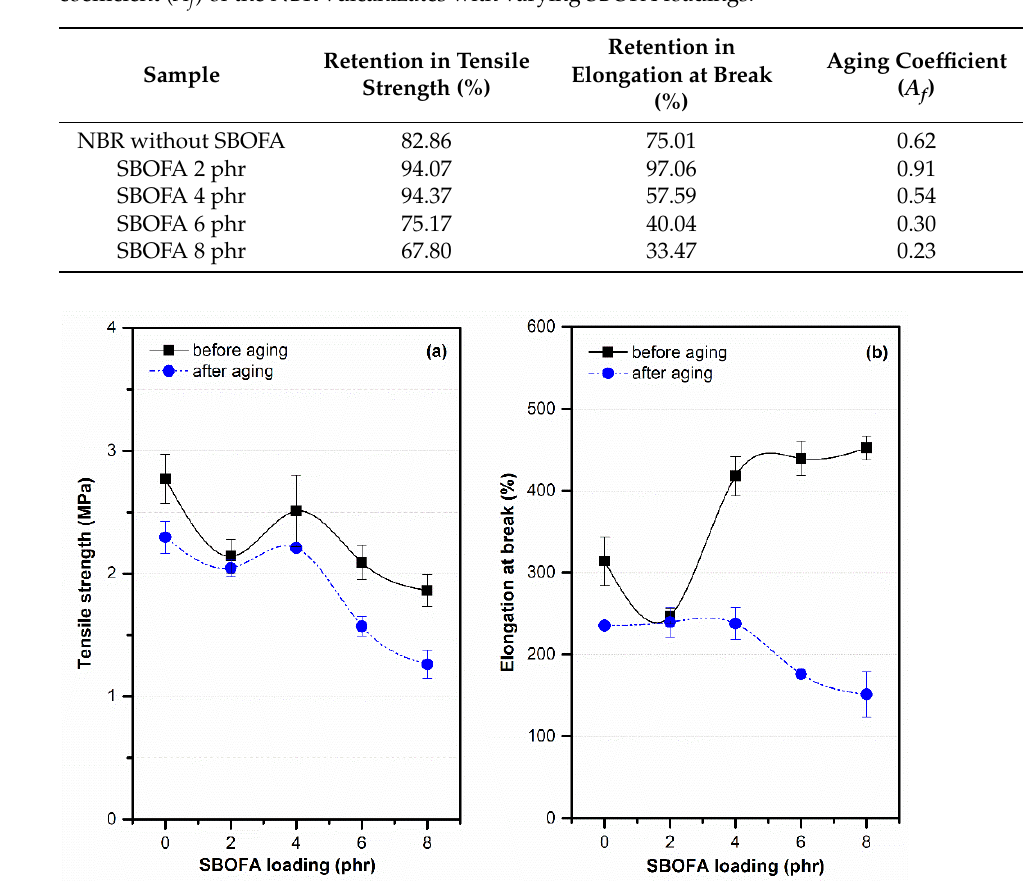
Figure 11. The ( a ) tensile strength and ( b ) elongation at break of NBR vulcanizates with varying SBOFA loadings before and after thermal aging at 100°C for 48 h. Data are shown as the mean ± 1SD, derived from five experiments.